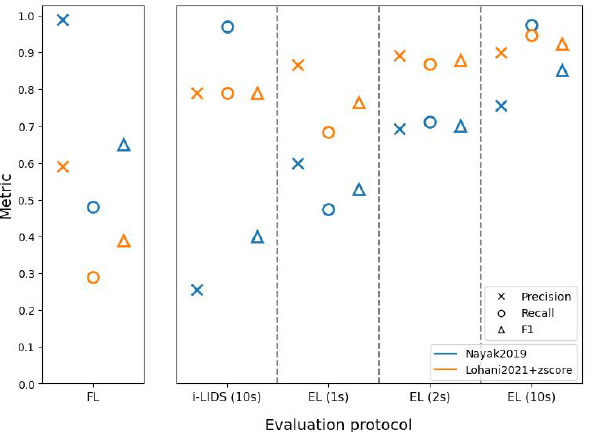
Figure 12. The results of two methods: Nayak et al. [47] (in blue) and Lohani et al. [6] with z-score (in orange), tested on view 1 of i-LIDS test set with intruder at mid distance from camera. The abscissa represents three evaluation protocols: frame-level (FL) (on left subfigure), i-LIDS and edge-level (EL) (on right subfigure). i-LIDS is evaluated by default for 10 s whereas, for EL, we show results for 1, 2 and 10 s. The ordinate represents values of three metrics: precision, recall and F 1 score.